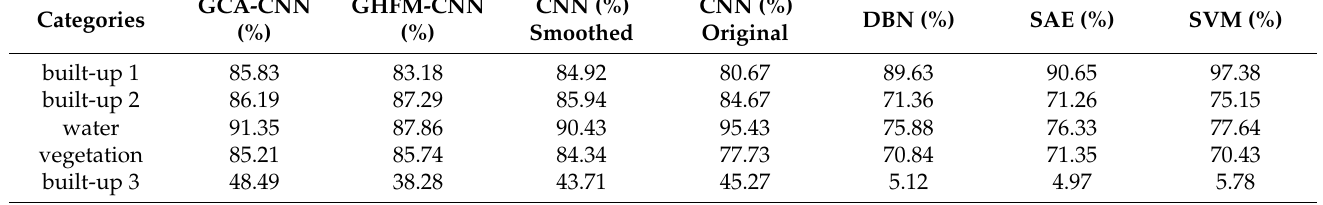
Figure 11. The confusion matrices of the ( a ) GCA-CNN, ( b ) GHFM-CNN and ( c ) OI-CNN on the SanFransisco-Bay image. Table 2. Accuracies of algorithms on SanFrancisco-Bay SAR image.